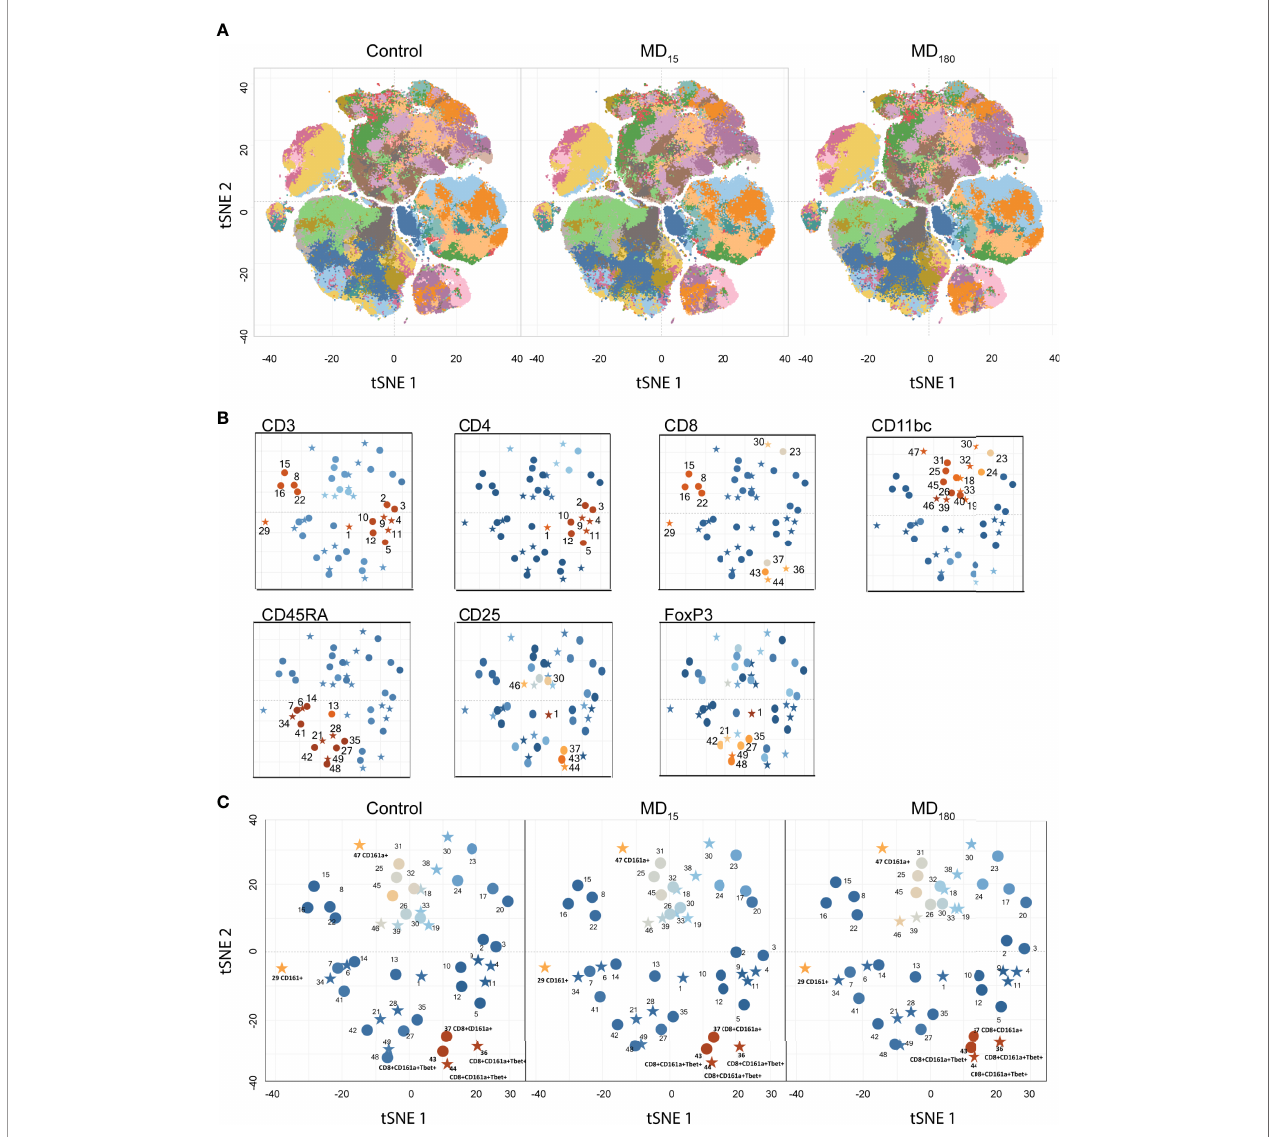
FIGURE 2 | Unbiased immunophenotyping with viSNE. (A) visNE map obtained through cytobank with the markers a single 13-color antibody combination. Each panel represents the mean of all 12 animals in the control (left), MD 15 (middle) and MD 30 (right) groups; (B) Identi fi cation of different clusters by the principal rat cell surface markers – CD3 CD4, CD8, CD11b/c, CD45RA, FoxP3. Stars represent signi fi cantly different clusters, between the different treatment groups at an FDR corrected p < 0.05; (C) Clusters colored by CD161a (NK cell marker) intensity. Blue to orange: low to high expression of the